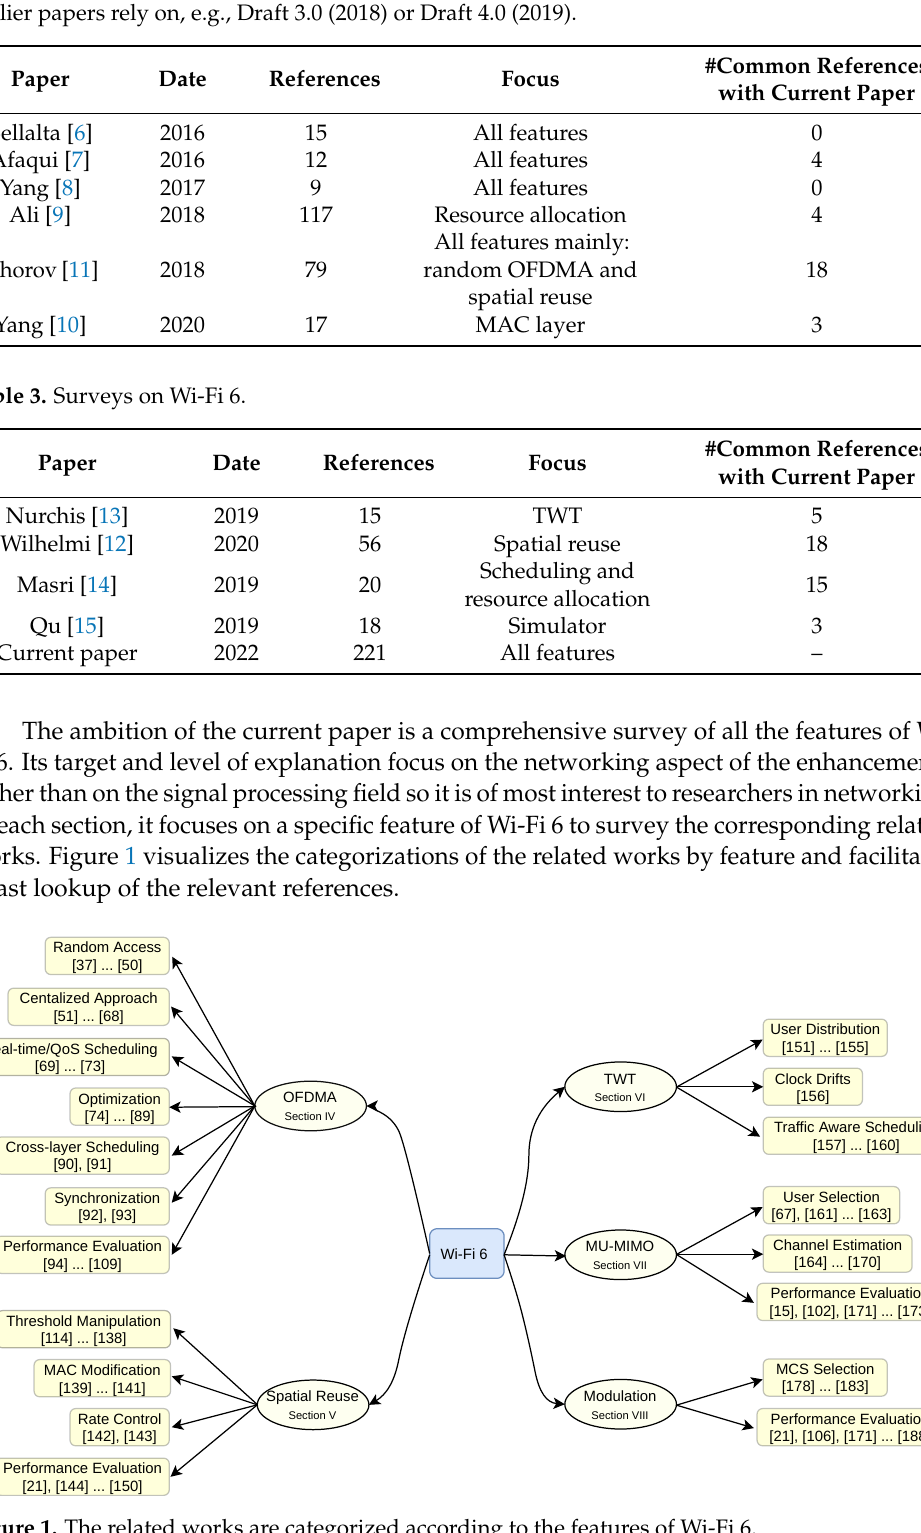
Figure 1. The related works are categorized according to the features of Wi-Fi